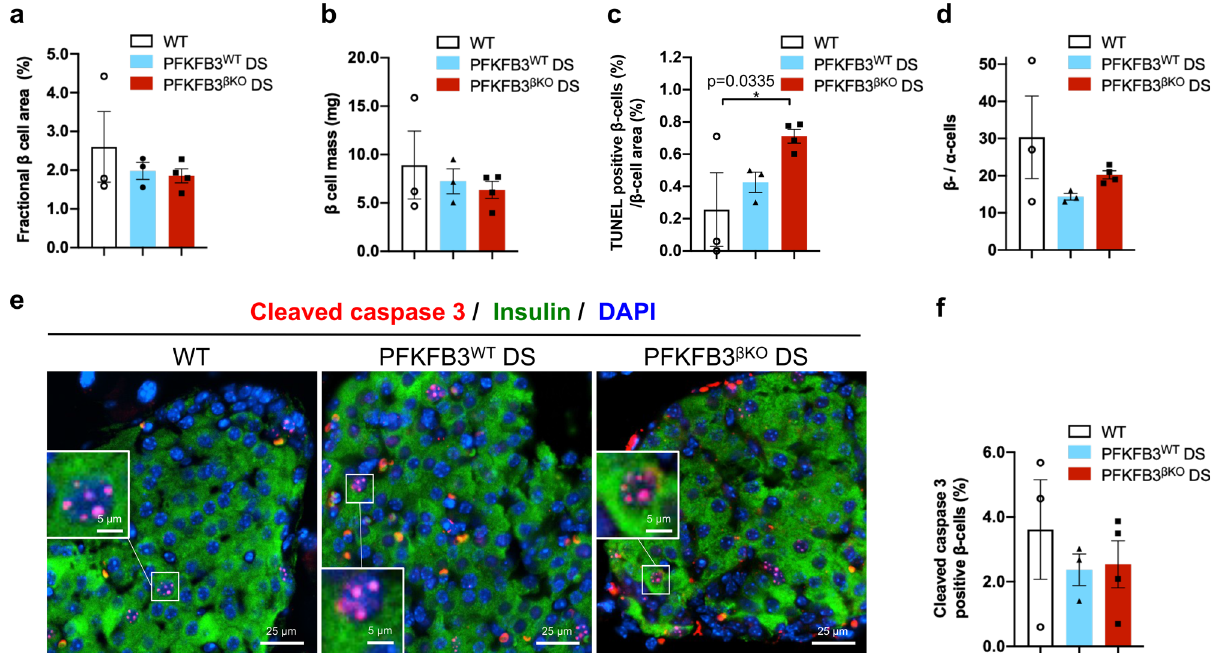
Fig. 8 PFKFB3 β KO DS high mice show increased β -/ α -cell ratio in spite of the increase in the β -cell death relative to PFKFB3 WT DS mice. a Quanti fi cation of fractional β -cell area (%). b Quanti fi cation of β -cell mass (mg). c Quanti fi cation of β -cell death as measured by labelling with TUNEL assay (%) represented relative to fractional β -cell area (* p = 0.0335). d Quanti fi cation of β -cell relative to α -cell number in indicated experimental groups. e Representative immuno fl uorescence images of islets from WT, PFKFB3 WT DS and PFKFB3 β KO DS mice immunostained for cleaved caspase-3 (red), insulin (green) and nuclei (blue). f Quanti fi cation of images under ( e ) ( n = 3, n = 4 for PFKFB3 β KO DS-independent animals,